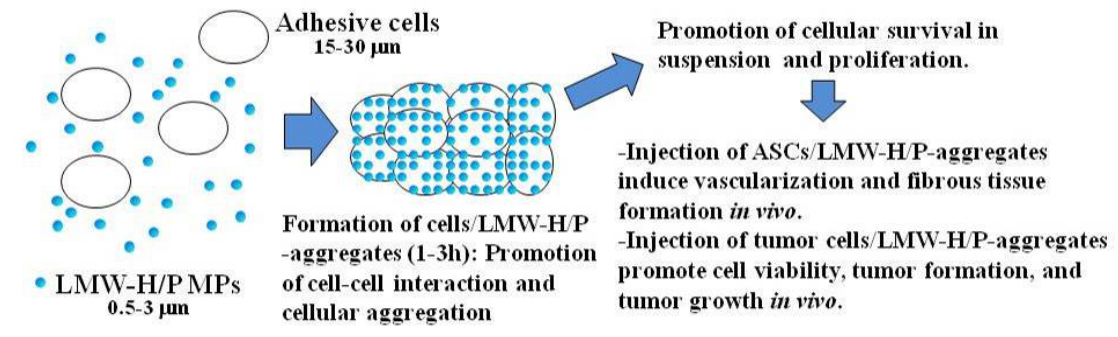
Figure 5. Mechanism on formation of cells/LMW-H/P MPs-aggregates as cell carrier.